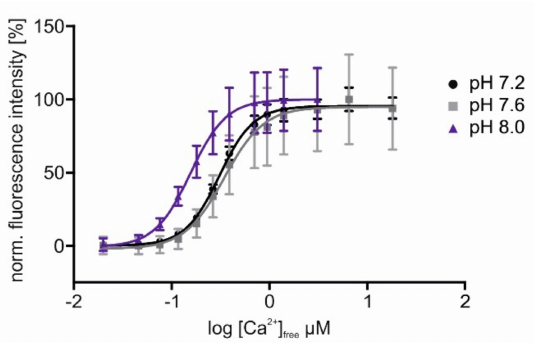
Figure 3. In vitro characterization of GCaMP3.0mito at different pH values. The GCaMP3.0mito construct was designed for localizing to the mitochondrial matrix. For in vitro characterization of the protein, the recombinant was cloned into pRSET A vector, over-expressed in E. coli (BL21(DE3)LysS cells and affinity purified via Ni-NTA agarose. Purified GCaMP3.0mito protein (2 µ M final concentra- tion) was diluted in an incubation buffer (30 mM MOPS, 100 mM KCl at pH 7.2 (black), pH 7.6 (gray), or pH 8.0 (purple)) and adjusted to the desired [Ca 2+ ] free with CaEGTA (10 mM)/K 2 EGTA (10 mM). For each [Ca 2+ ] free , the fluorescence emission spectrum was registered upon excitation at 470 nm. Fluorescence intensities at 510 nm were normalized to the highest fluorescence intensity (=100%) obtained at the different pH values. Mean values from five independent experiments were plotted against log [Ca 2+ ] free . The Ca 2+ -concentration–response curves were calculated with GraphPad Prism (5.04).